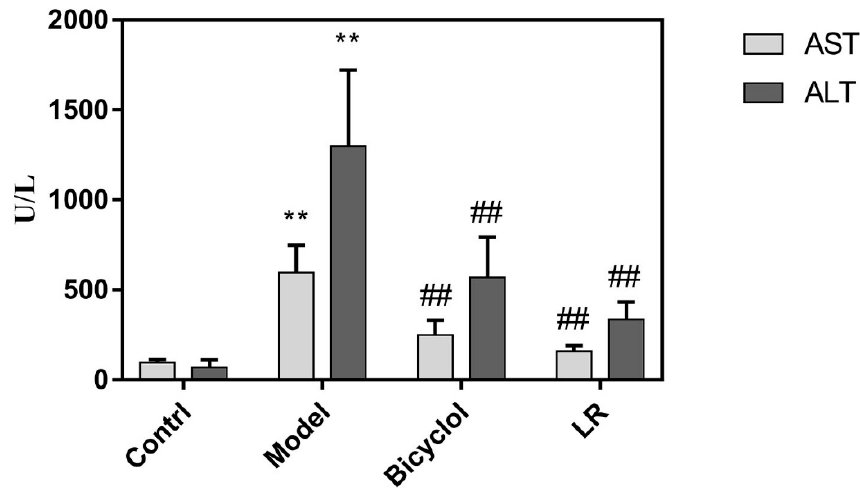
Figure 1. The serum levels of ALT and AST in mice from control, model, bicyclol, and LR groups (Mean ± SD). **: p < 0.01 (in comparison with control group, t -test); ## : p < 0.01 (in comparison with model group, t -test).